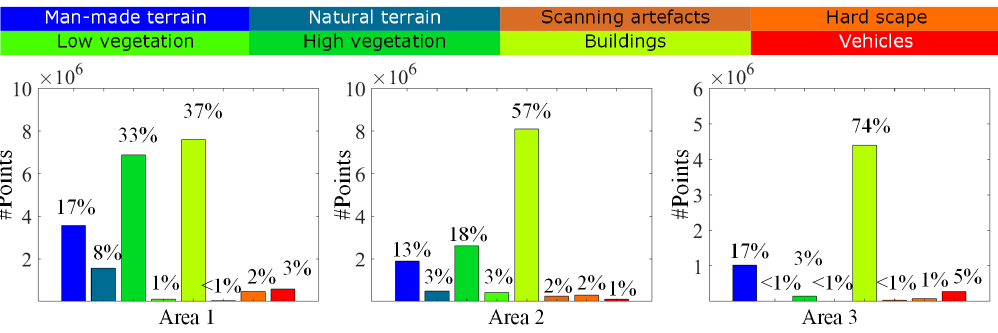
Figure 6. Percentage of labeled points in the three different areas.